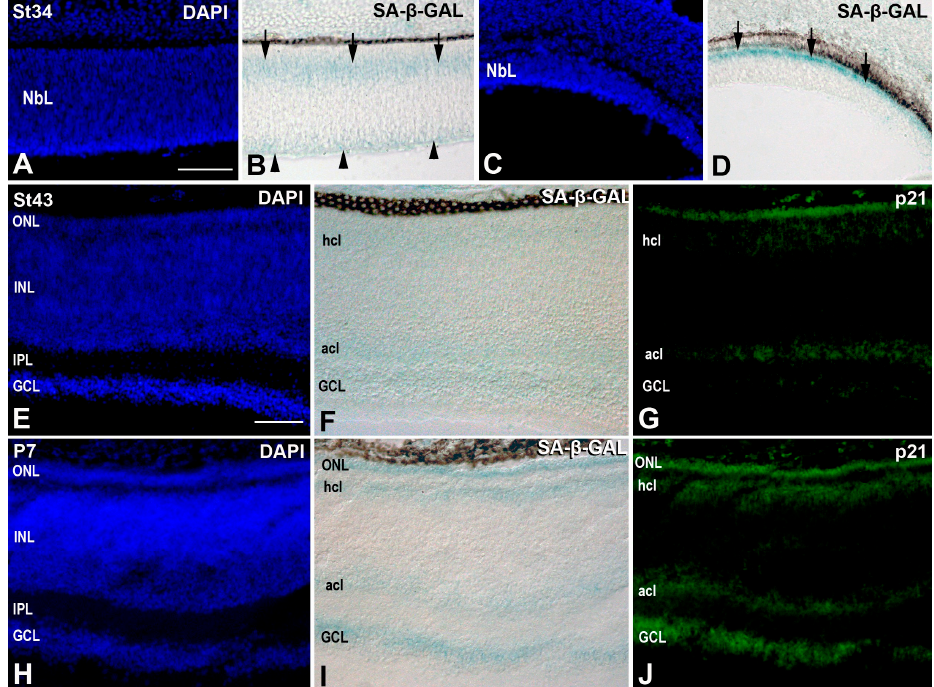
Figure 8. Distribution of SA- β -GAL labeling and p21 immunoreactivity in retinal cryosections of embryos ( A – G ) and post-hatched specimens ( H – J ) of T. guttata . All sections were counterstained with DAPI. DAPI staining showed that at St34, the retinal tissue comprised an NbL ( A , C ). SA- β -GAL activity presented two bands of labeling located in the vitreal and scleral regions of the NbL in the central retina ( B ), but in a single band located sclerally in the peripheral retina ( D ). At St43 and P7, DAPI staining revealed the central retina to present a multi-laminated structure ( E , H ). SA- β -GAL activity was mainly detected in the GCL, amacrine cell layer, horizontal cell layer, and photoreceptor cell layer ( F , I ). The p21 immunosignal was highly coincident with SA- β -GAL staining ( G , J ). Abbreviations: acl, amacrine cell layer; GCL, ganglion cell layer; hcl, horizontal cell layer; INL, inner nuclear layer; IPL, inner plexiform layer; NbL, neuroblastic layer; ONL, outer nuclear layer; OPL, outer plexiform layer. Scale bars: 50 µm.